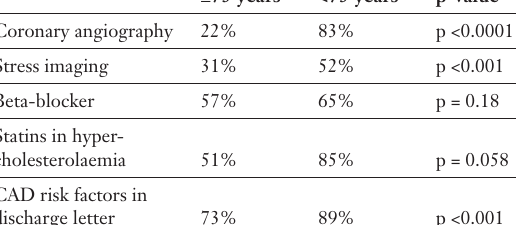
Results in the ACS group.